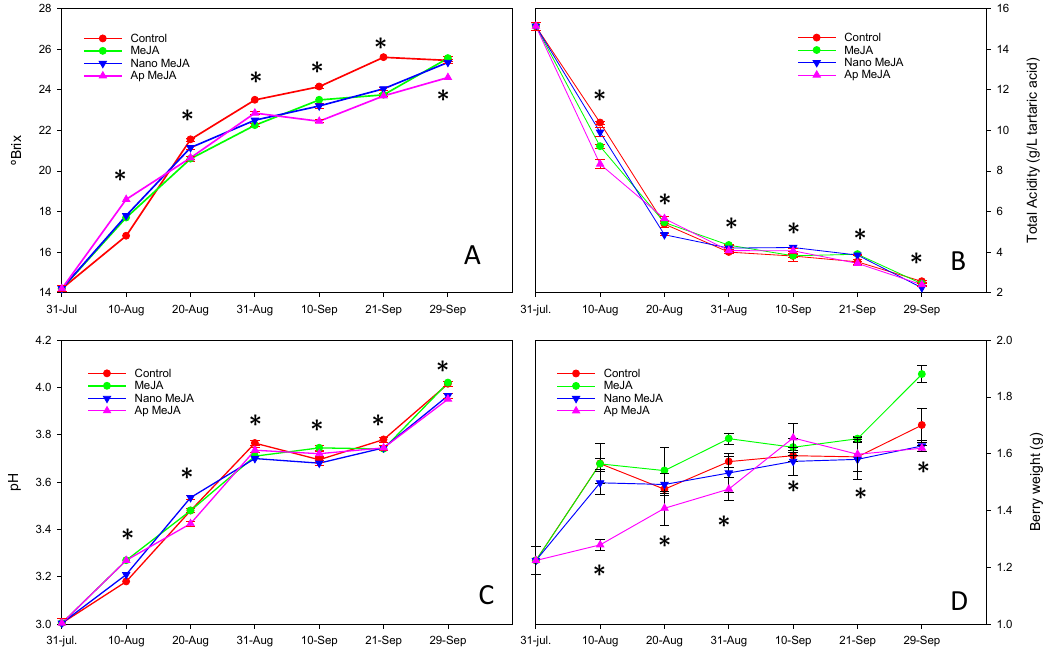
Figure 2. Physicochemical parameters in grapes during ripening period (( A ) evolution of ◦ Brix; ( B ) evolution of total acidity; ( C ) evolution of pH and ( D ) evolution of berry weight). Abbreviations: MeJA: methyl jasmonate; Nano-MeJA: methyl jasmonate adsorbed on amorphous calcium phosphate; Ap-MeJA: methyl jasmonate adsorbed on nanocrystalline apatite. * Indicates significant differences among treatments according to Duncan’s test ( p < 0.05).